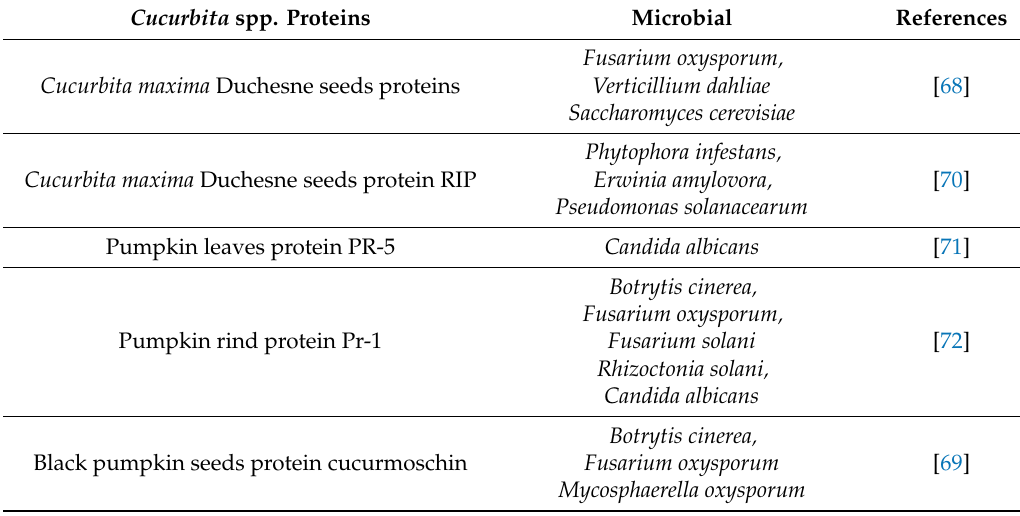
Table 4. In vitro antimicrobial activity of Cucurbita spp.